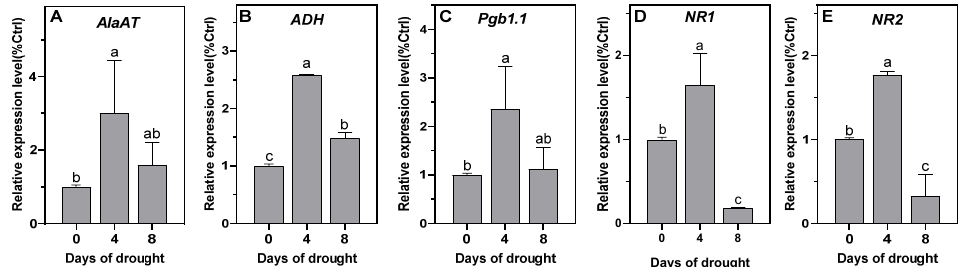
Figure 3. Effects of water deprivation on the relative expression level of Vicia faba nodule genes: alanine aminotransferase ( A ), alcohol dehydrogenase ( B ), phytoglobin1.1 ( C ), nitrate reductase 1 ( D ), and nitrate reductase 2 ( E ). The relative expression of each gene is expressed as the percentage of the control (T = 0) values. Data are means ± SD of three biological replicates. Letters above the bars represent significant differences according to one-way ANOVA at p < 0.05 (Tukey’s multi-comparison test). AlaAT, alanine aminotransferase; ADH, alcohol dehydrogenase; Pbg1.1, phytoglobin 1.1; NR1, nitrate reductase 1; NR2, nitrate reductase